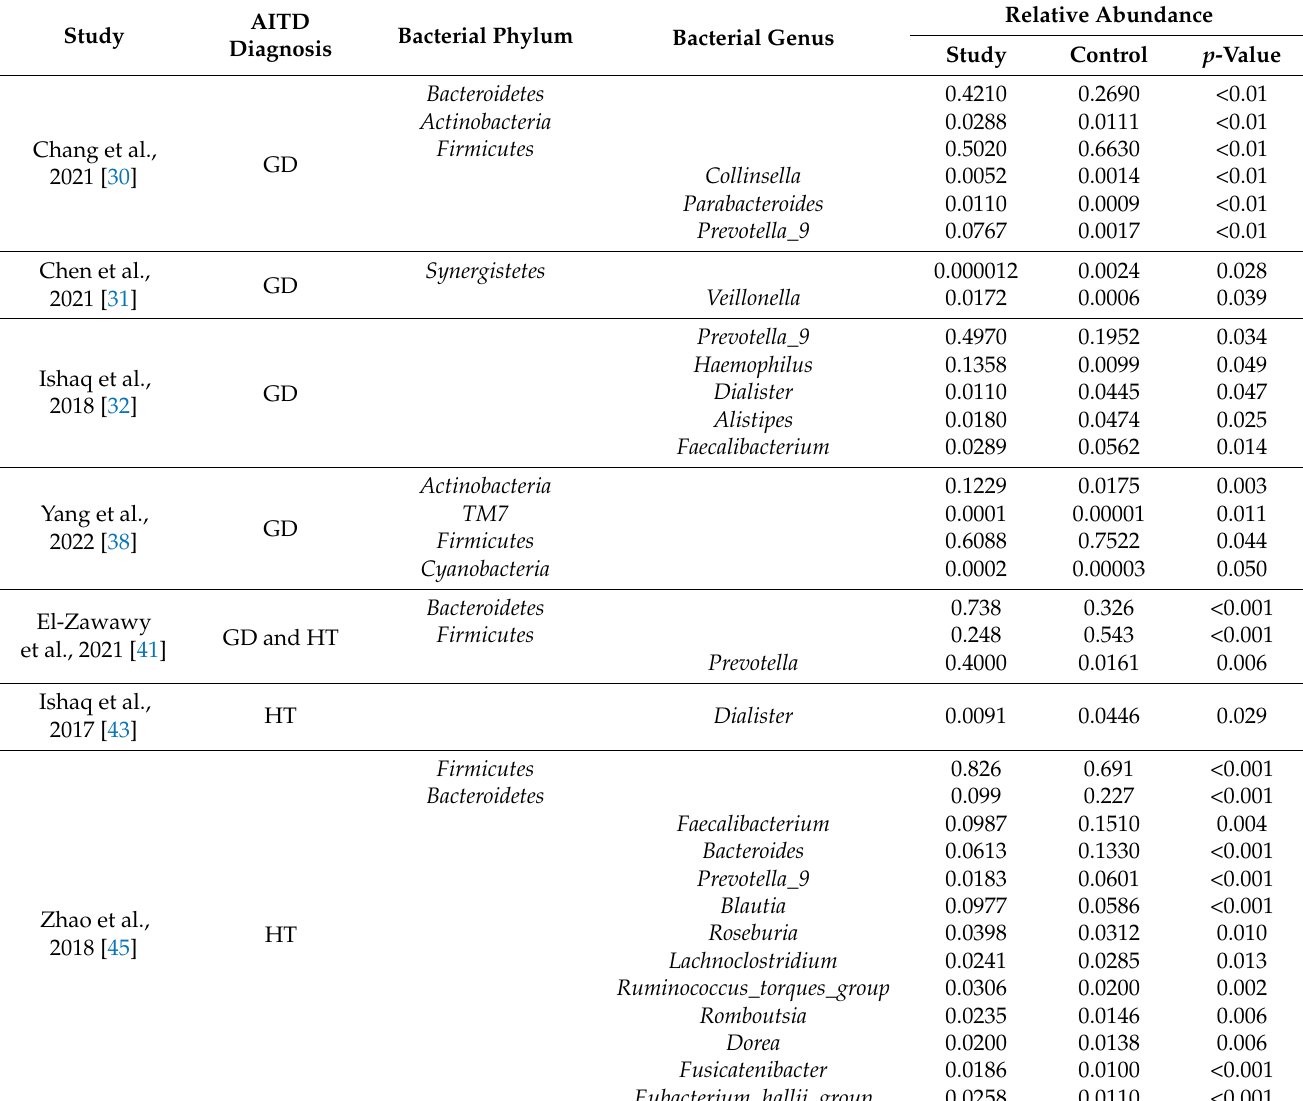
Table 3. Relative abundance of significantly altered microbiota in autoimmune thyroid disease